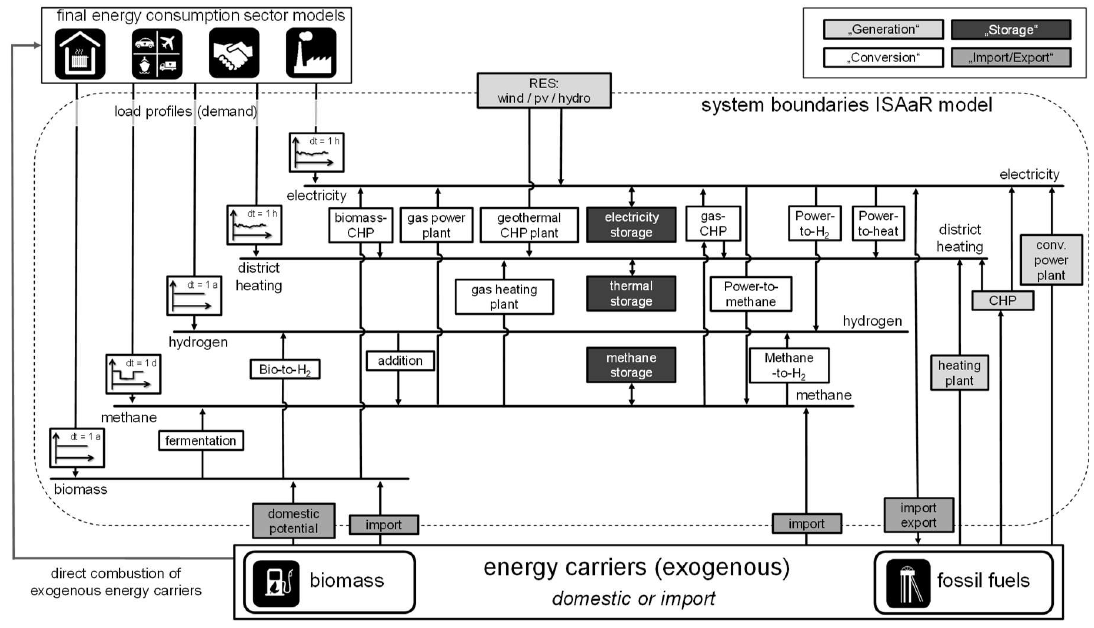
Figure 1. Multi-energy carrier model “ISAaR”.